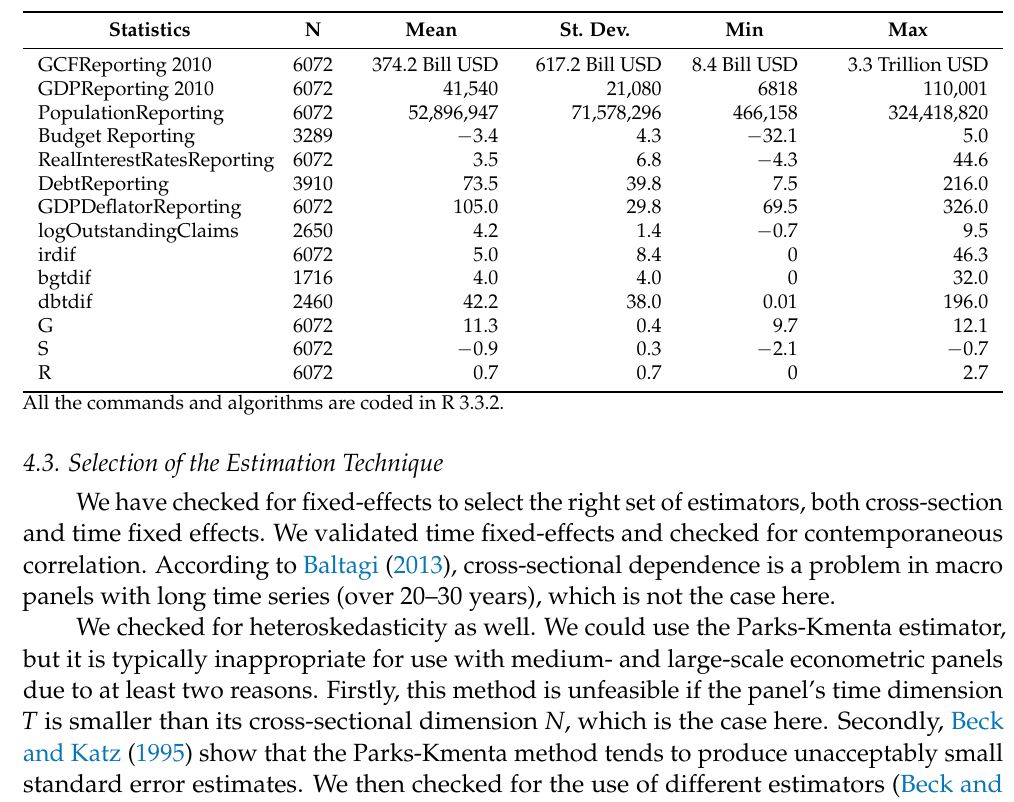
Table 1. Summary